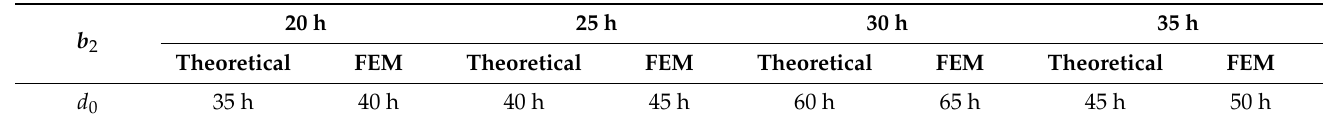
Table 3. The safe distance d 0 between the two resonator units under different electrode width b 2 of Ru-B.